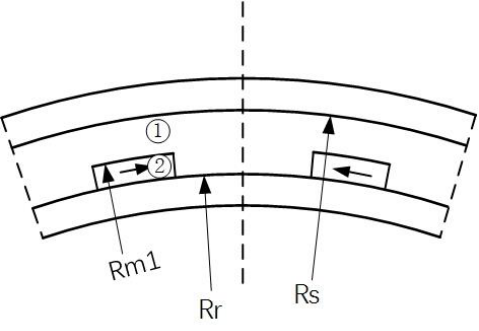
Figure 5. Auxiliary pole of Halbach array.